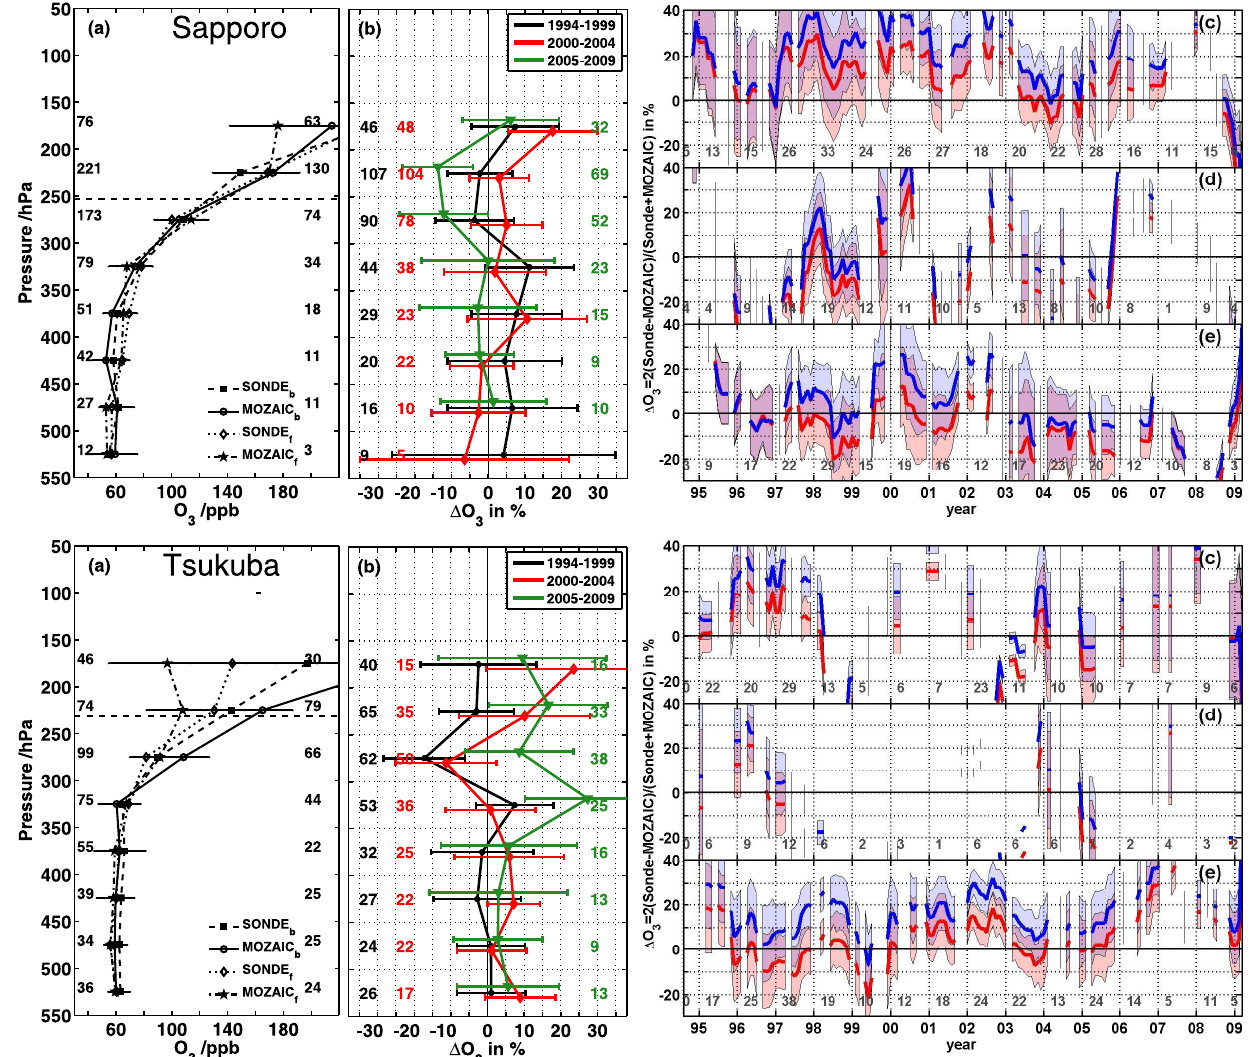
Fig. 10. Comparisons of ozonesondes and MOZAIC measurements. As for Fig. 3, but for Sapporo and Tsukuba.